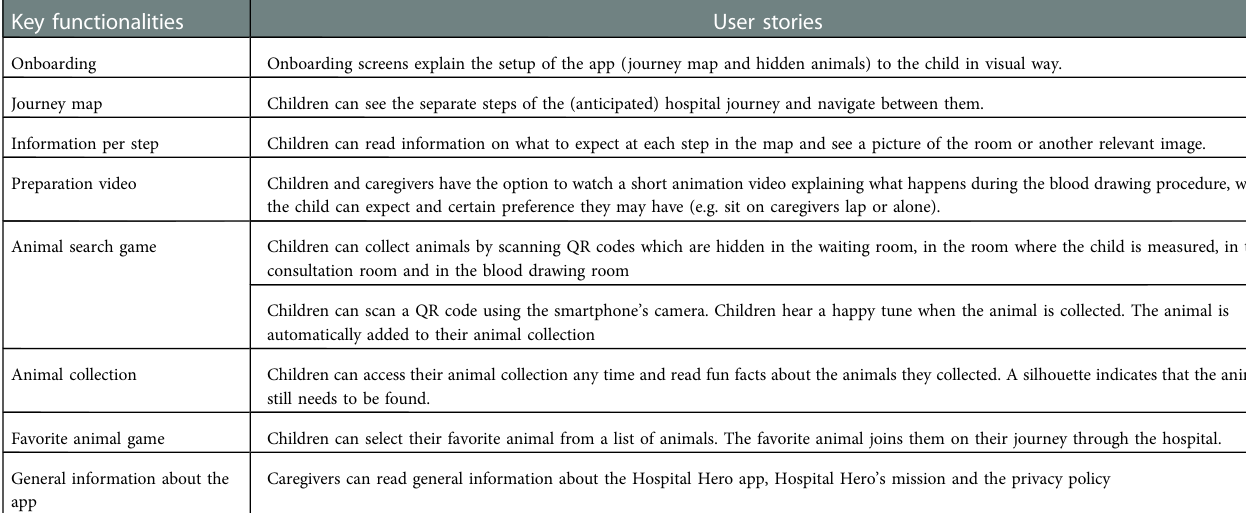
Favorite animal game